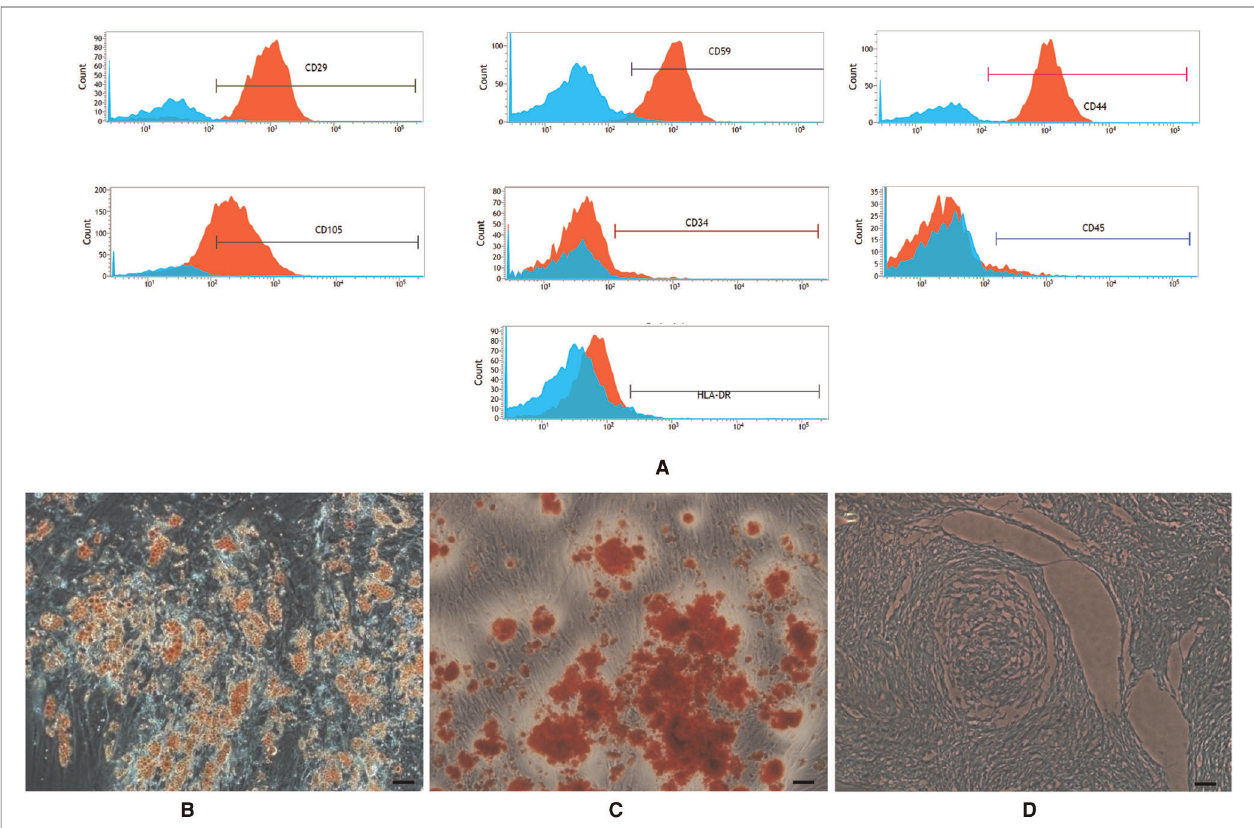
FIGURE 1 | ( A ) expression of surface marker of the third generation of ADSCs. Flow cytometry labeling of surface markers showed ( B – D ): Multi-lineage differentiation potential of adipose-derived stem cells (ADSCs). ( B ) Oil Red O staining. ( C ) Alizarin red staining. ( D ) Alcian blue staining (scale bars=50